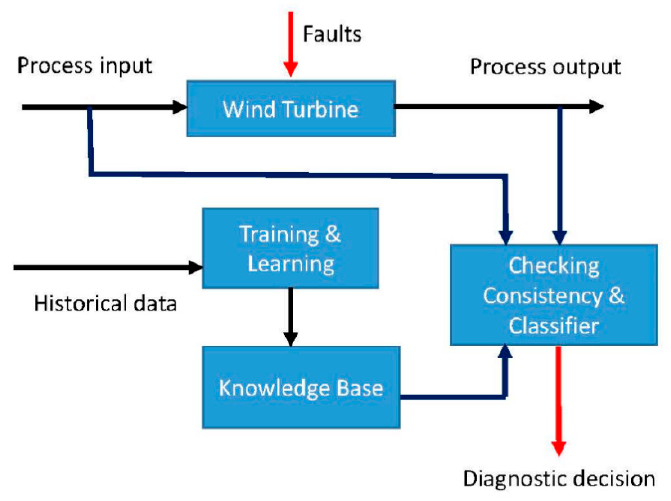
Figure 6. Schematic diagram of knowledge-based fault diagnosis.